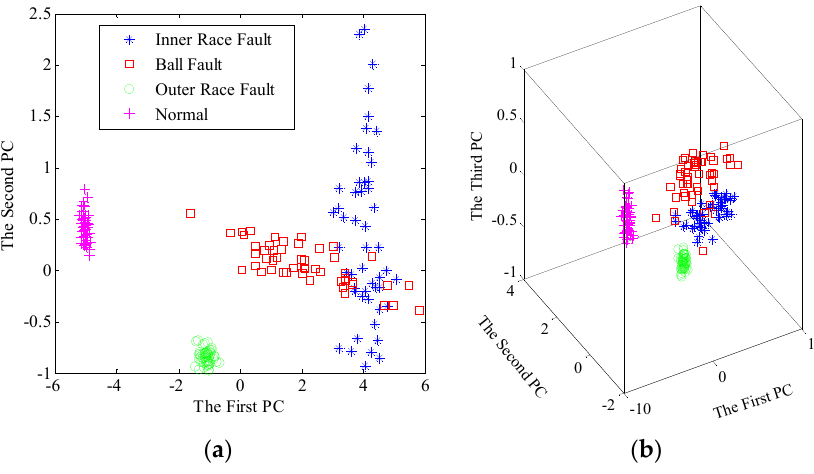
Figure 10. Scatter plots of the principal components after dimensionality reduction using dictionary learning and SVD: ( a ) the first two principal components; ( b ) the first three principal components.